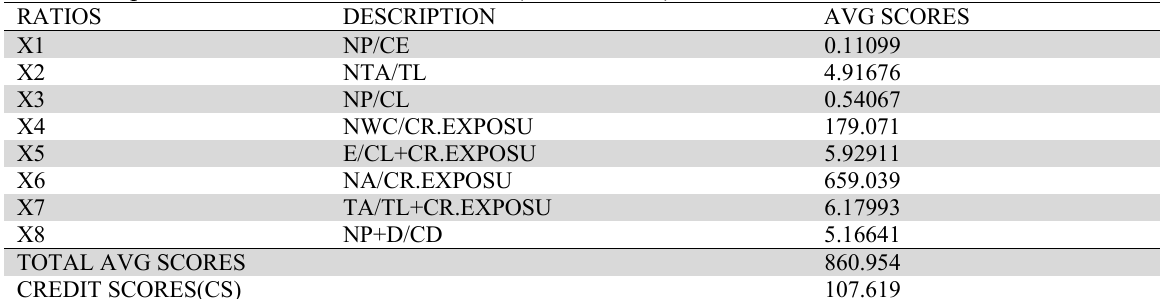
Risk description model –Ratio measurement (Gini